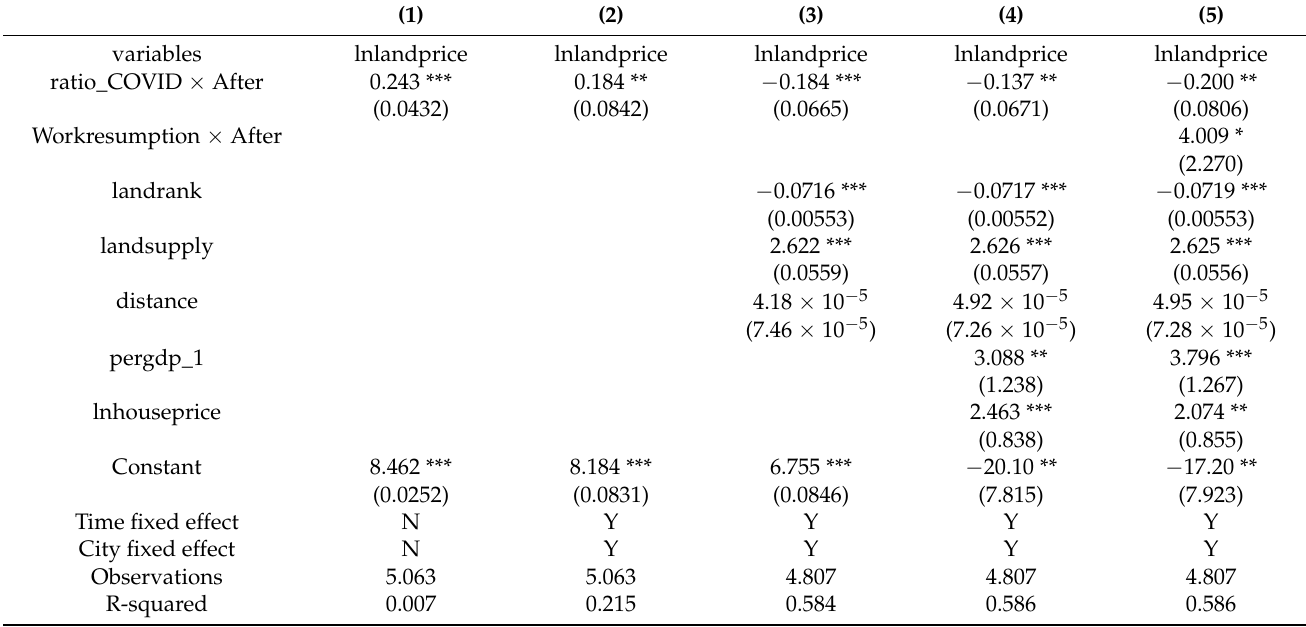
Table 2. The empirical results of COVID-19, urban resilience signals and residential land